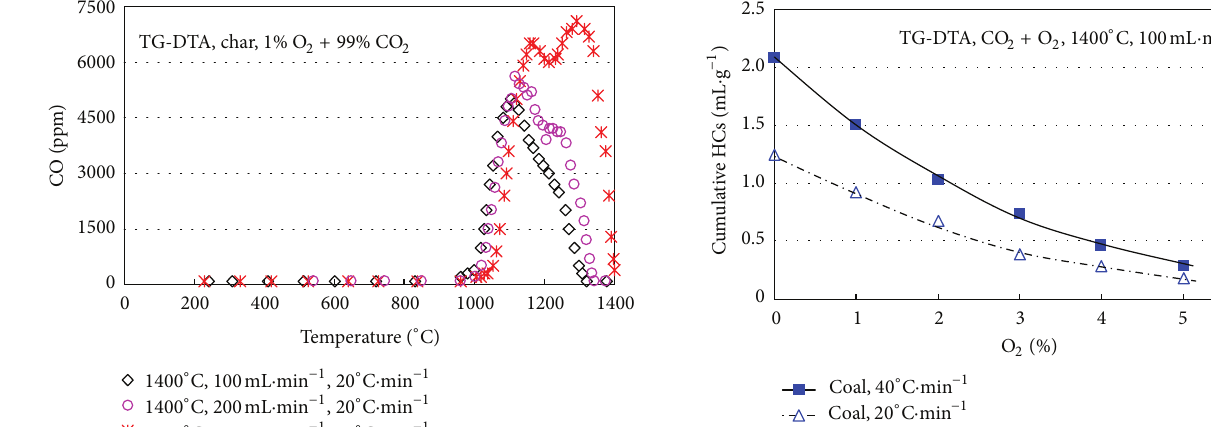
Figure 26: CO gas generation from char in 99% CO 2 + 1% O 2 gas flow with different temperature gradients and gas flow rates.